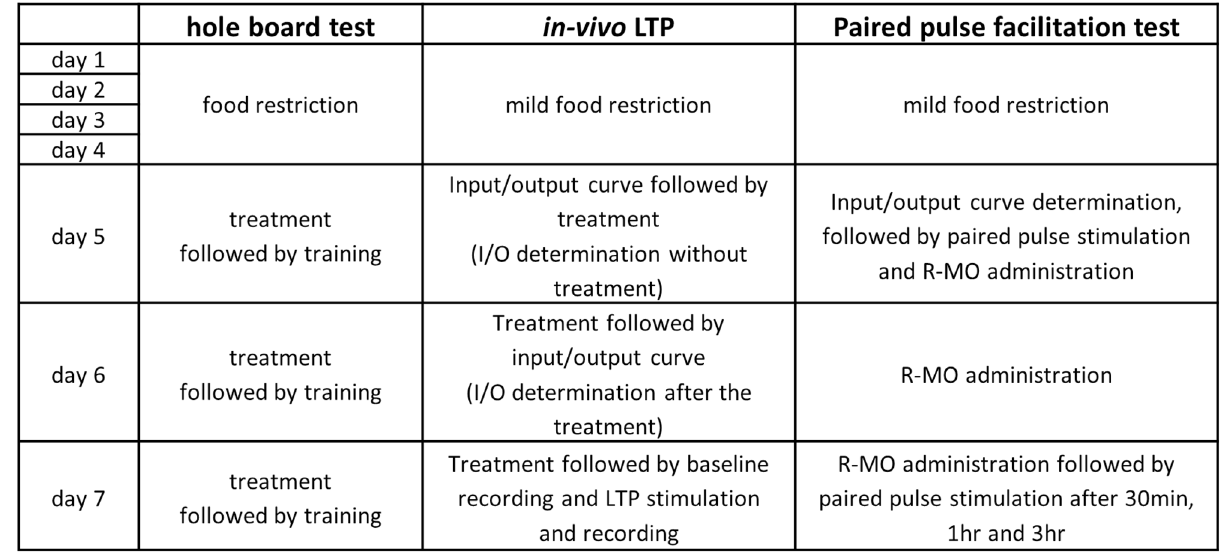
Fig 1. Experimental design of the hole-board and LTP experiments. For in vivo LTP and pairedpulse facilitation test, treatment frequency and procedure was designedthat matches with the hole-board test protocol. The term ‘treatment’ impliesthat the animals either administered with R-MO or DMSO or saline 30 min before the start of the actual